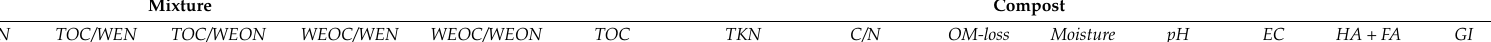
Table 8. Pearson’s correlation coefficients between selected parameters of the mixtures and composts studied. Mixture